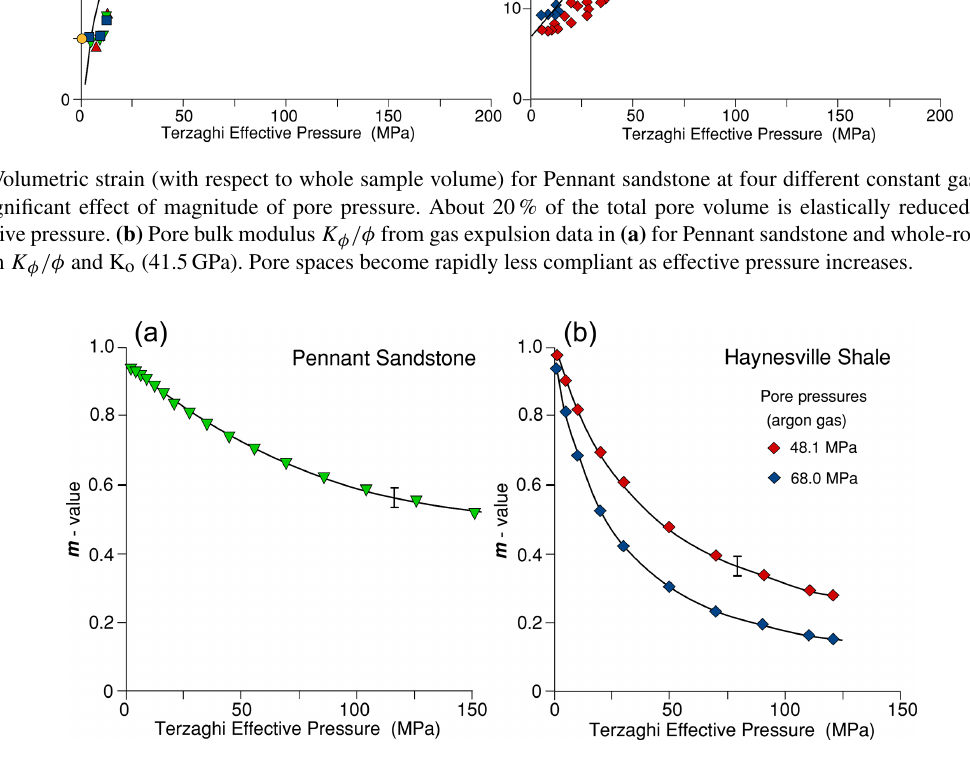
Figure 7. m from bulk modulus data and Eq. (7) for (a) Pennant sandstone and (b) Haynesville shale. The decrease in m with P eff arises from the stiffening of the pore spaces with effective pressure, and the effect is greater for the shale than for the